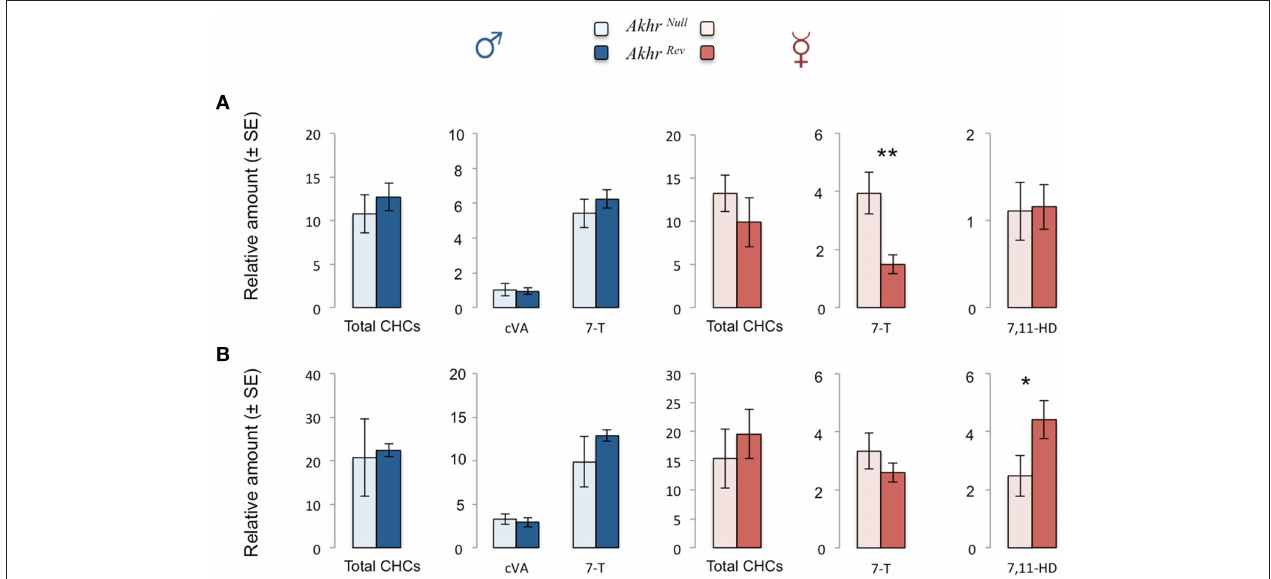
FIGURE 3 | Effect of AKHR on CHC and cVA production in starved (A) and fed (B) flies. Relative amounts of total CHCs produced by Akhr null and Akhr rev flies as well as cVA and 7-Tricosene (7-T) produced by males and 7-T and 7,11-Heptacosadiene (7,11-HD) produced by females. * p < 0.05 , ** p < 0.01 .